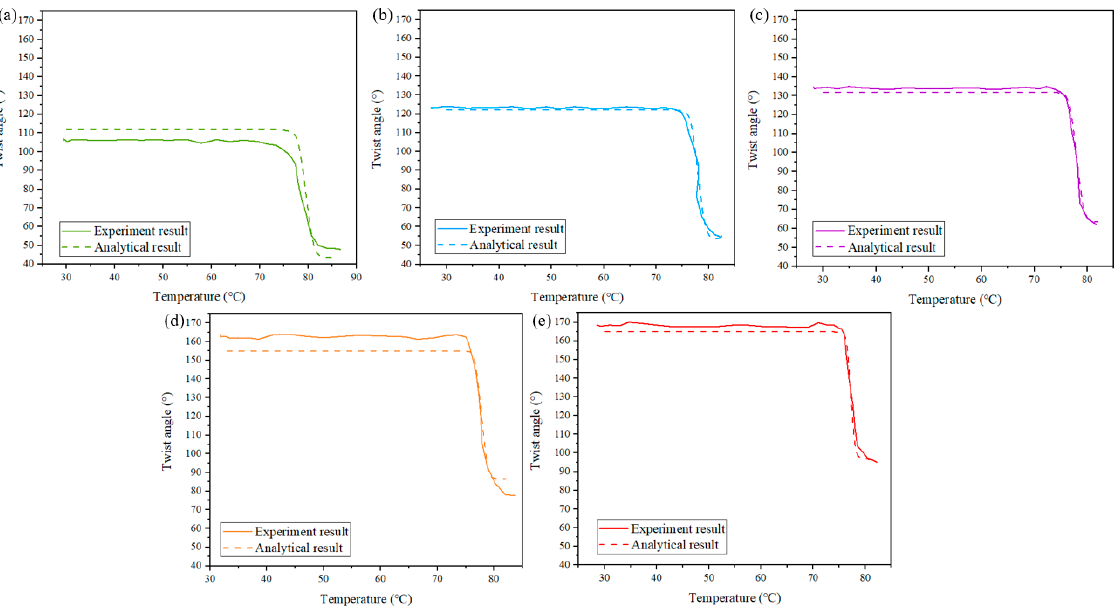
Figure 11. Experimental and analytical modeling results for SMAMS S2 subjected to applied torques corresponding to the 20th cycle. Torques are ( a ) 0.06 N · m, ( b ) 0.09 N · m, ( c ) 0.12 N · m, ( d ) 0.15 N · m and ( e ) 0.18 N ·